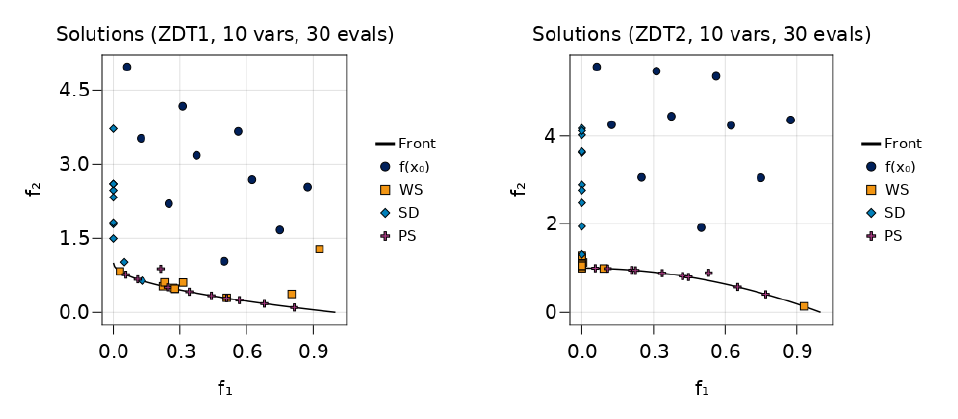
Figure 6. Final iterates in objective space for the bi-objective problems ZDT1 and ZDT2 in 10 variables. The weighted sum method (WS) is compared against the trust region method using steepest descent (DS) and the Pascoletti–Serafini (PS)